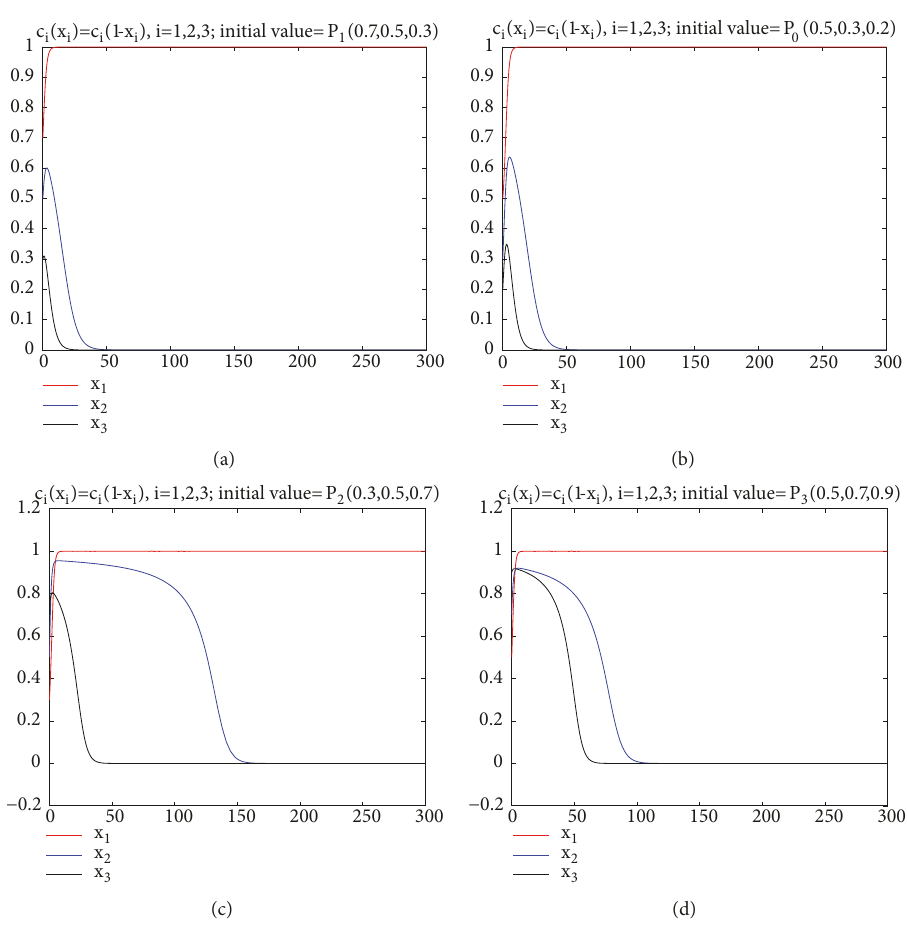
Figure 4: Time series graph of players’ strategy selection probability when costs become flexible. 𝑐 𝑖 (𝑥 𝑖 ) = 𝑐 𝑖 (1 − 𝑥 𝑖 ),𝑖 = 1,2,3 .